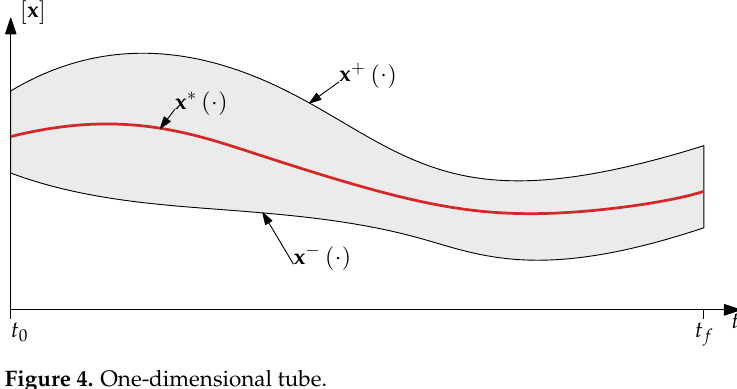
Figure 4. One-dimensional